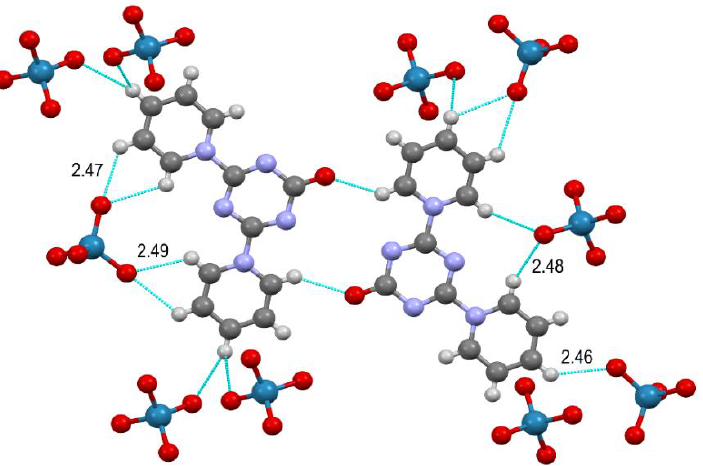
Figure 8. Dimer formed by cations linked by C-H … O contacts in the 4c structure. All the contacts with perrhenate ions which are not designated are longer than 2.50 Å .